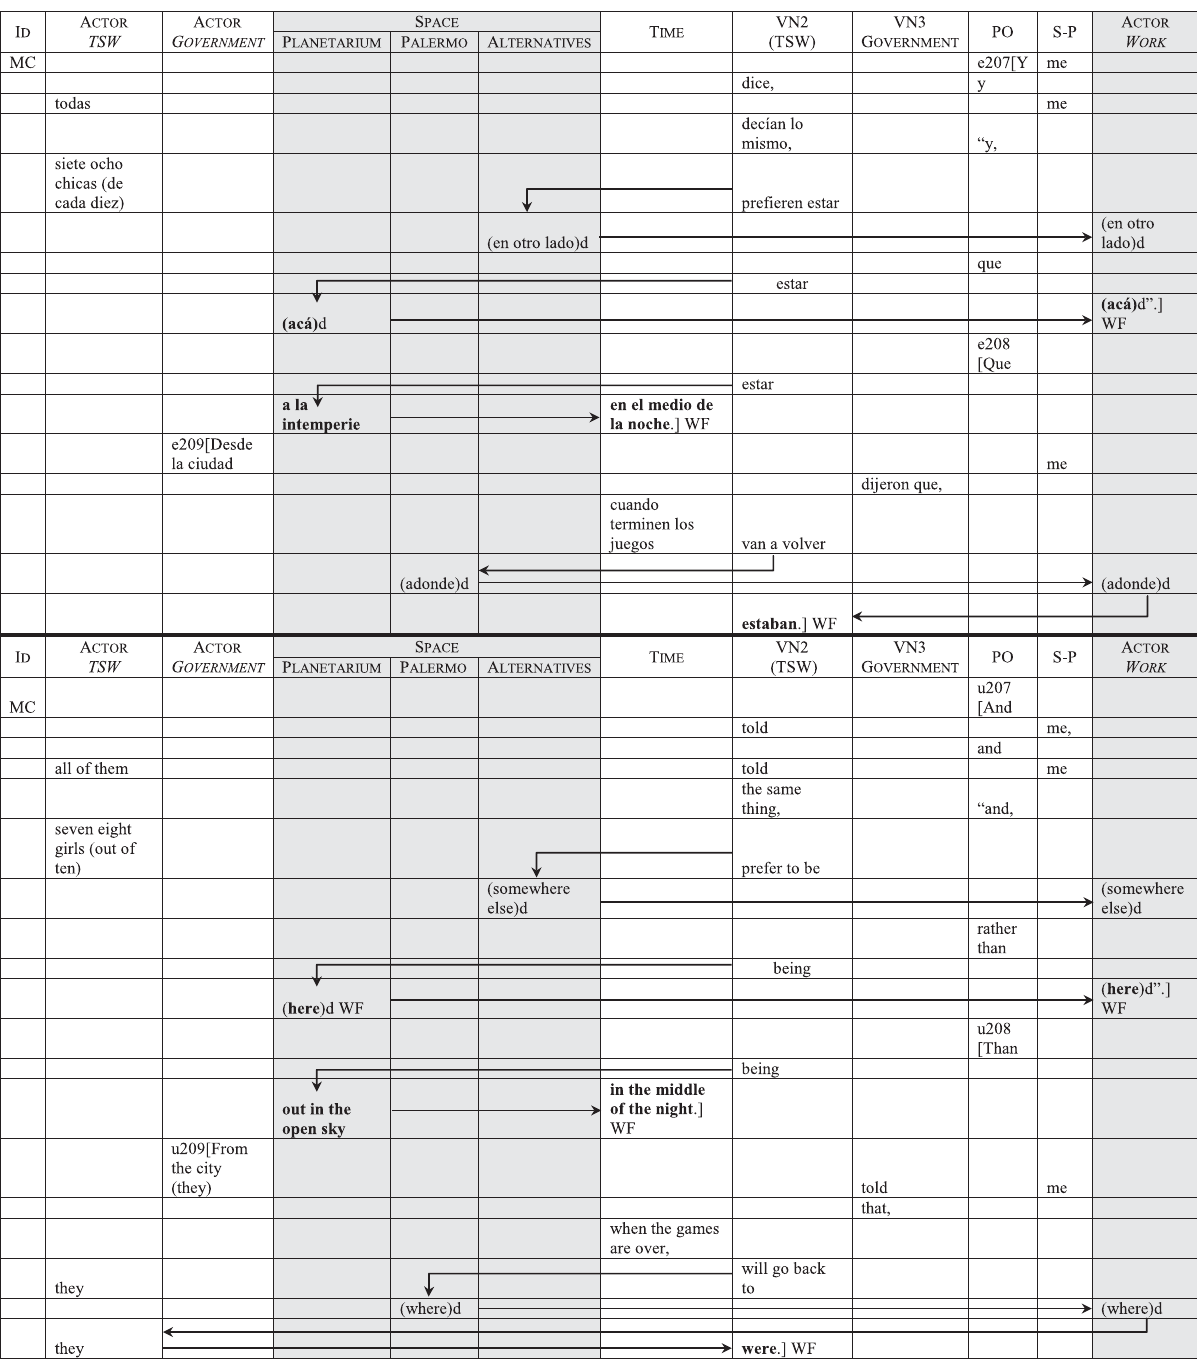
TABLE 13 | The naturalization of social exclusion in the closing editorial